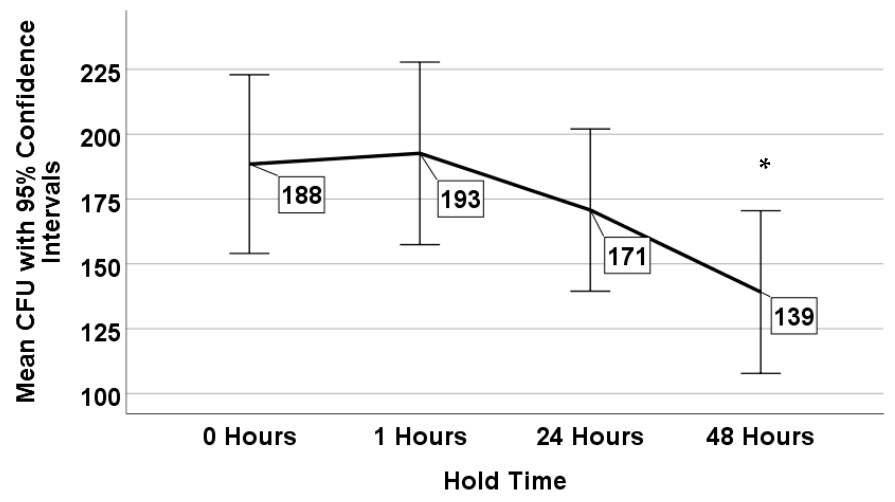
Figure 3. Mean Legionella counts (CFU/mL) as a function of hold time. * denotes a statistically significant difference ( p < 0.05).